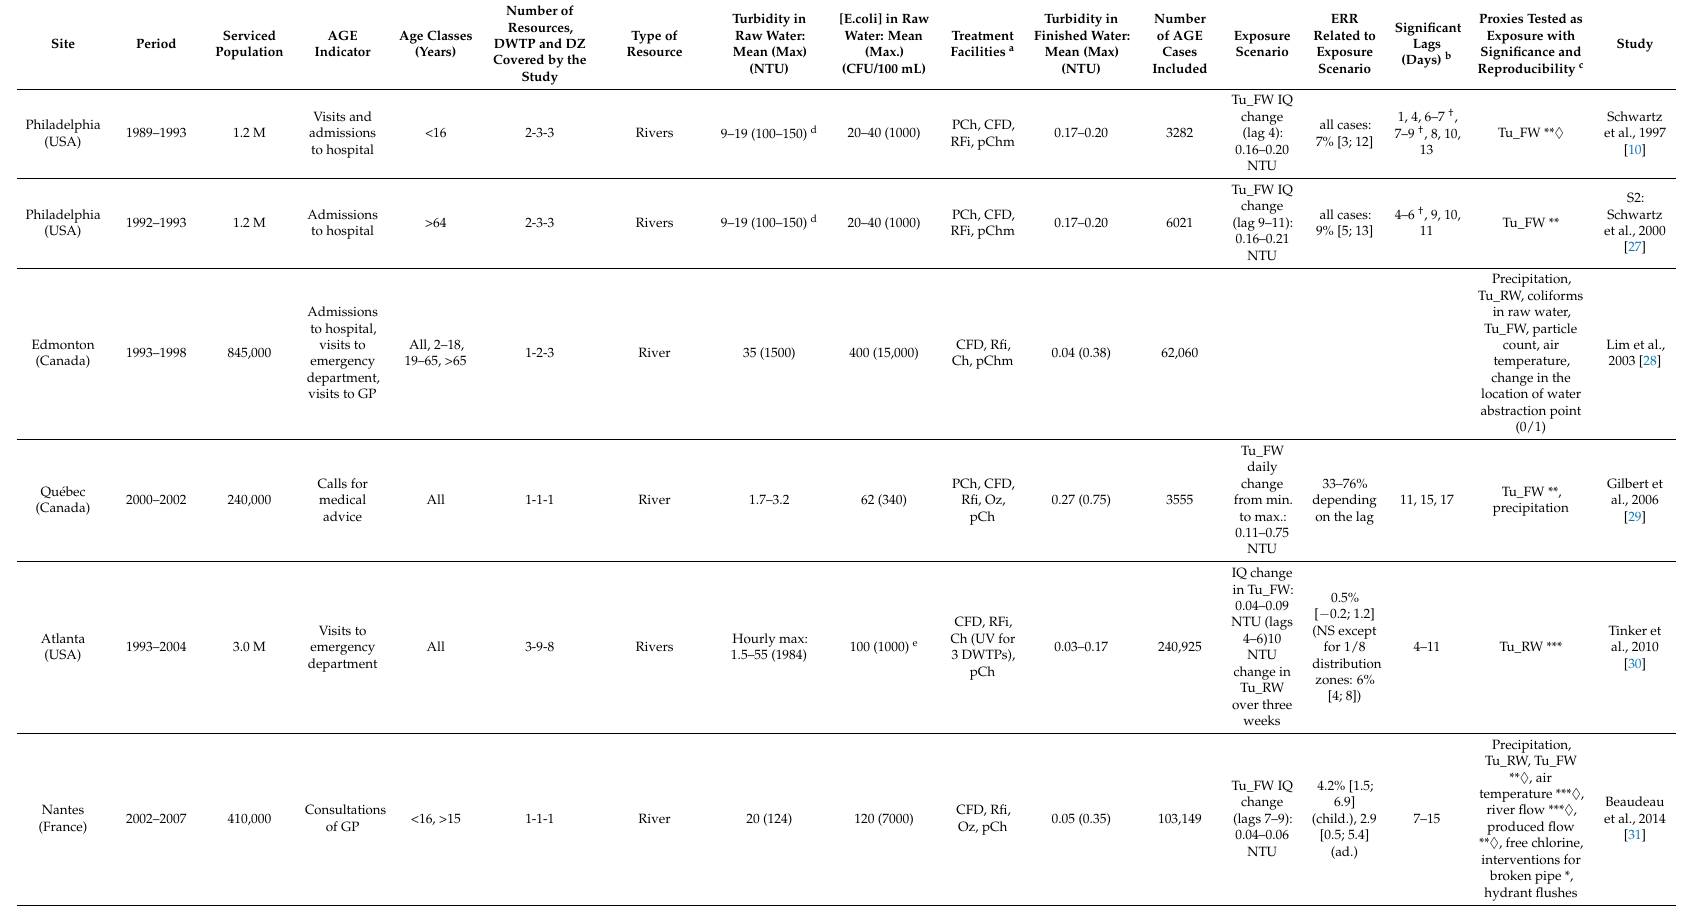
Table 1. Description of the selected sites and associated